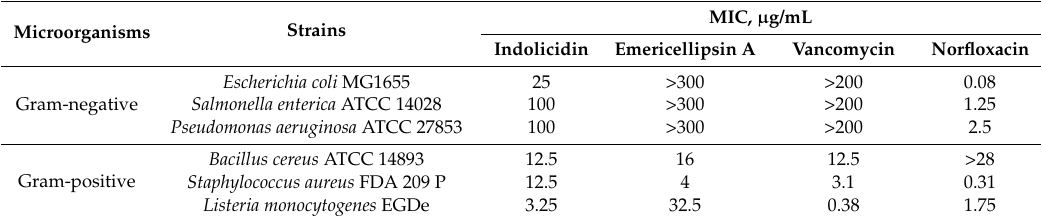
Figure 2. Structure of emericellipsin A determined by NMR spectroscopy. Numbering of amino and fatty acid residues is shown corresponding to the Table S1. Table 1. The antibacterial activity of emericellipsin A against bacteria.